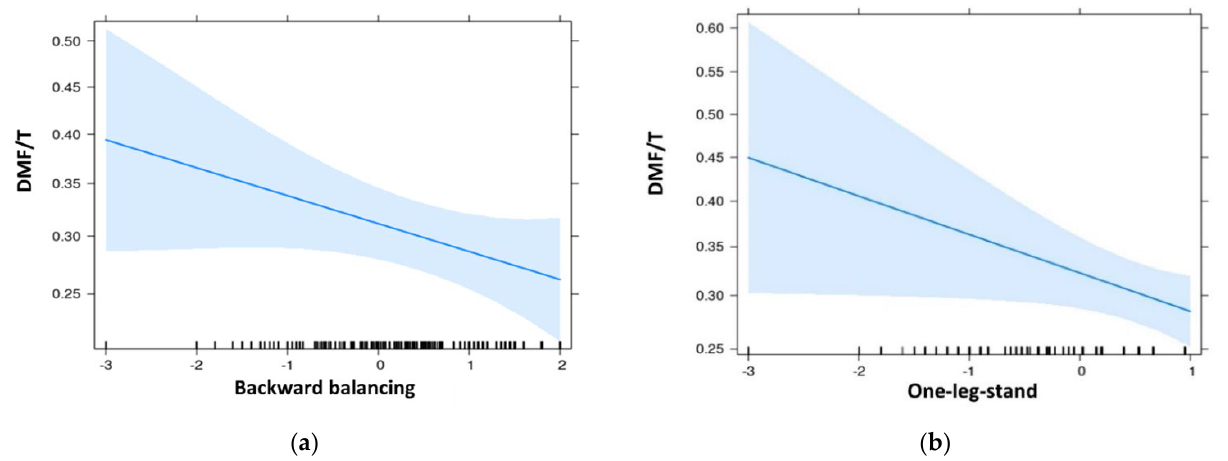
Figure 1. Effect plots of logistic regression analysis of DMF/T and coordination skills in children and adolescents of 10 to 18 years (Leipzig, Germany): ( a ) of the backward balancing test; ( b ) of the one-leg-stand test.